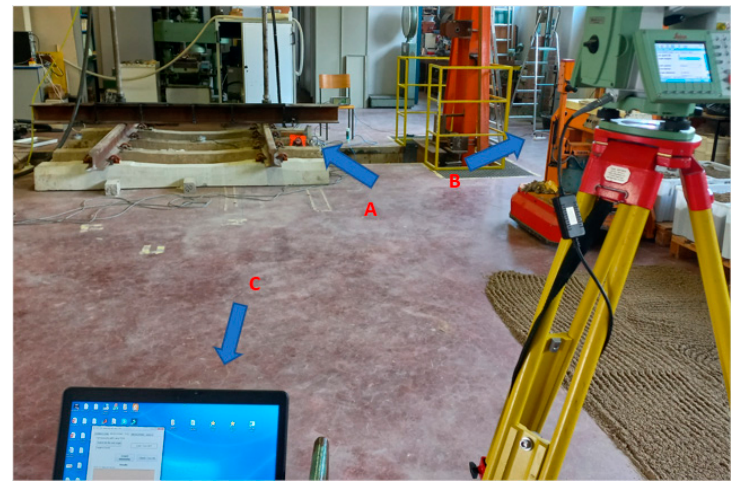
Figure 12. Geodetic measurement equipment. (A) Geodetic measurement point; (B) Leica TS50; (C) personal computer with GeoCOM/ZG software.